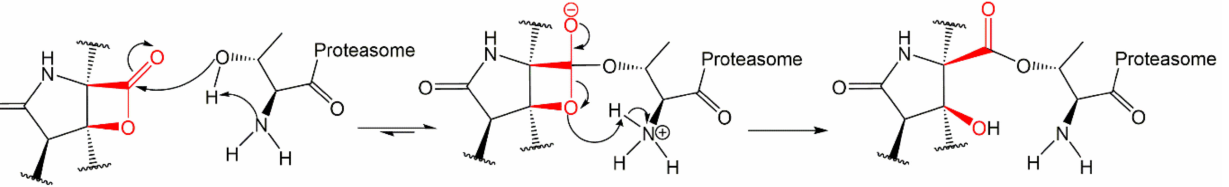
Figure 18. Mechanism of proteasome inhibition by β -lactone. The hydroxyl group from Thr1 reacts with the carbonyl group from the inhibitor, inducing the opening of the ring and acylation of hydroxyl from Thr1 [27,29].